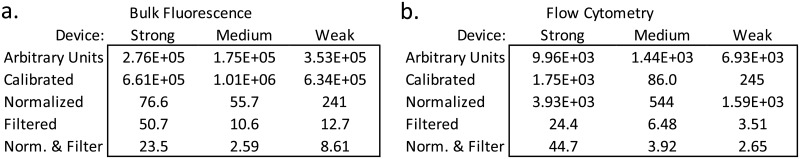
Fold range of 95% confidence interval vs. data treatment for (a) bulk fluorescence and (b) flow cytometry.